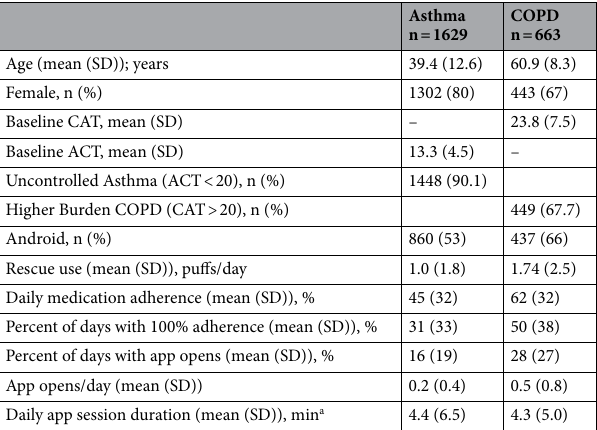
Table 1. Participant characteristics* *90 days of participant data included e.g., mean rescue puffs/day was calculated over 90 days. a Capped at 60